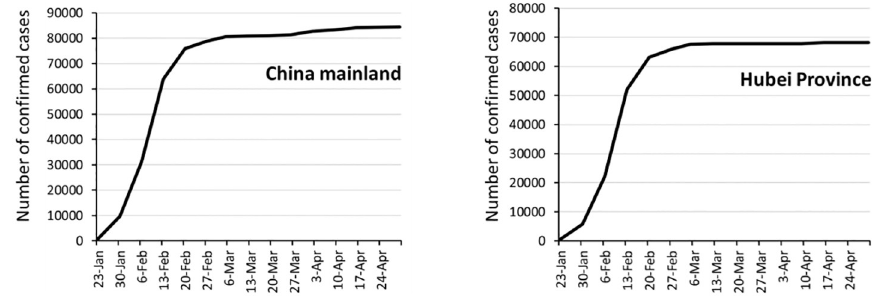
Fig 3. The number change of NCCC in China and Hubei province. (figure was drawn by author).